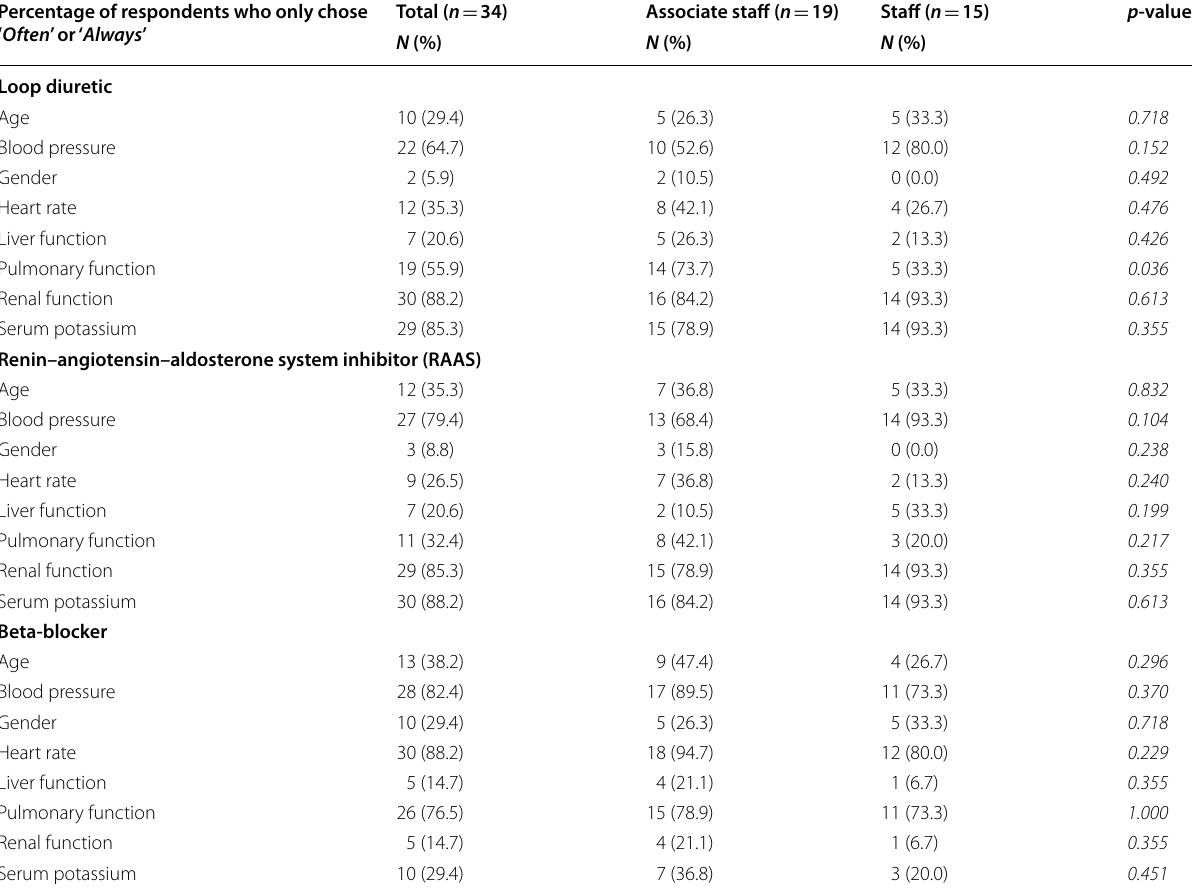
Table 1 Patient clinical factors influencing the prescribing choices of heart failure guideline-directed medicines Percentage of respondents who only chose ‘ Often ’ or ‘ Always